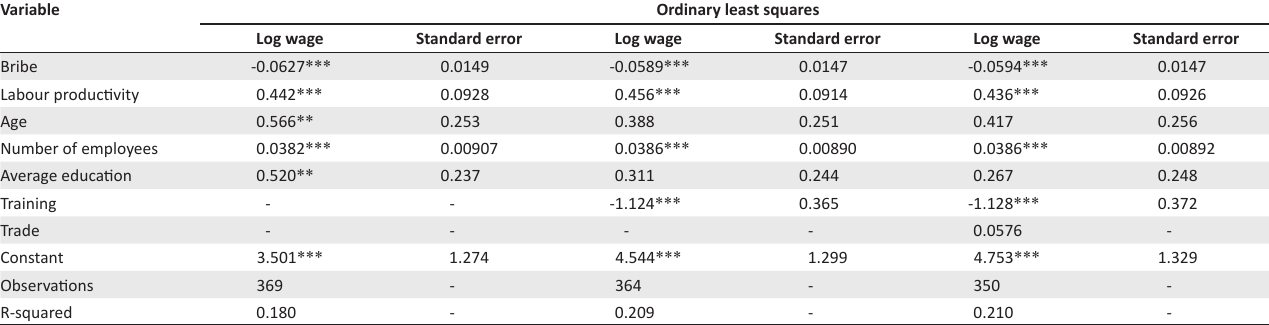
TABLE 4: Effect of bribery on wage payment, basic estimation.